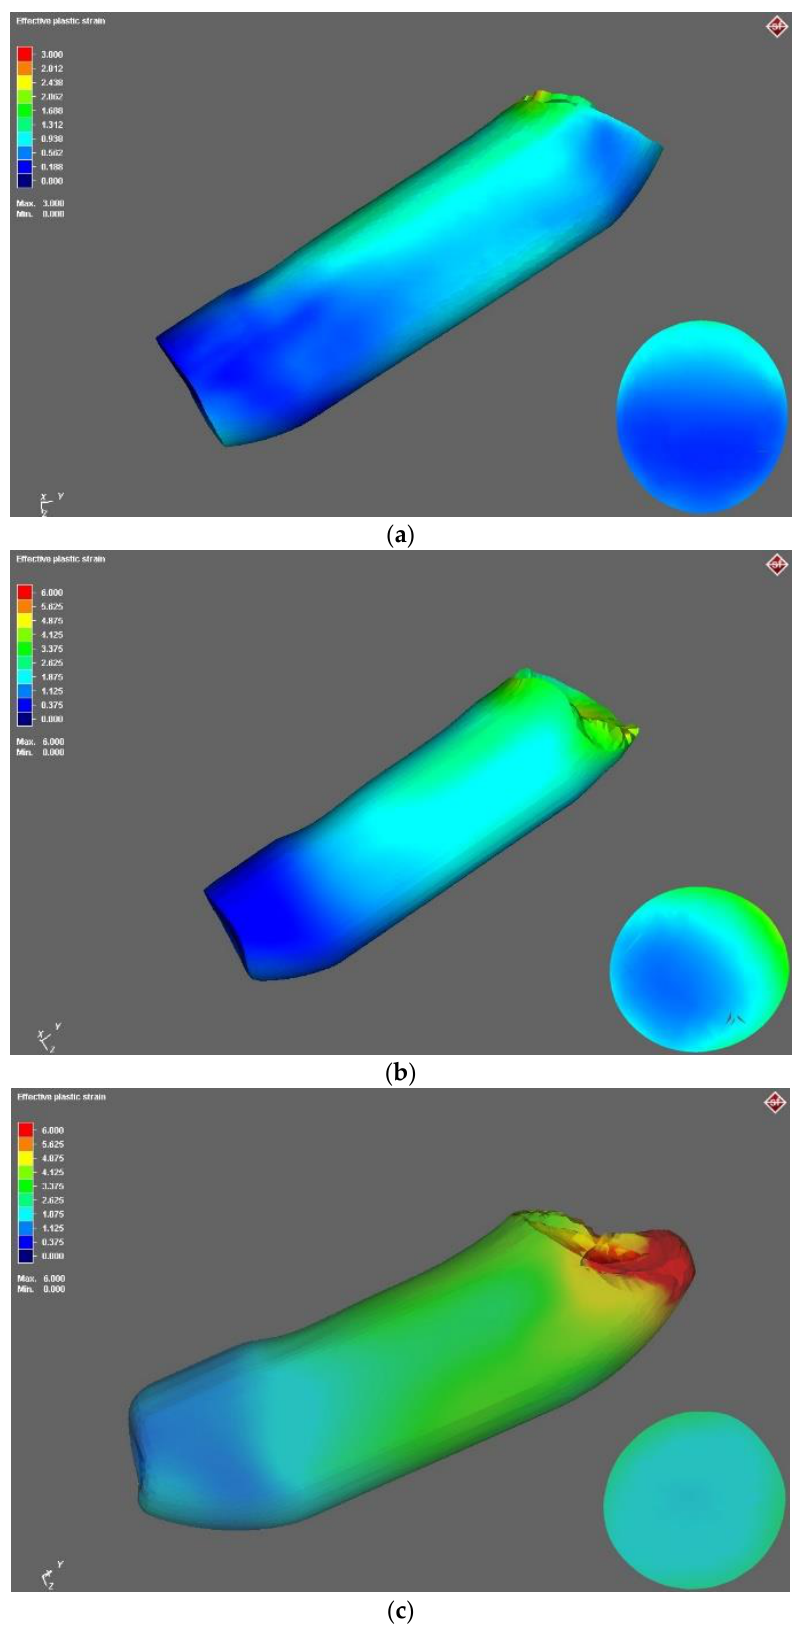
Figure 7. Strain distribution along both the LS and TS of the ECAPed AA2011 samples processed through 1- p ( a ), 2-Bc ( b ) and 4-Bc ( c ) at 150 ◦